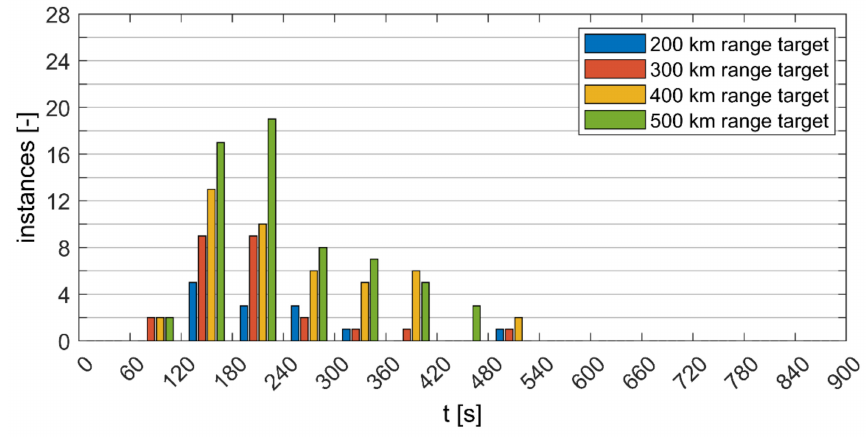
Figure A3. REX engagement instances binned by engagement time for CLTC-P and vehicle mass of 1800 kg.